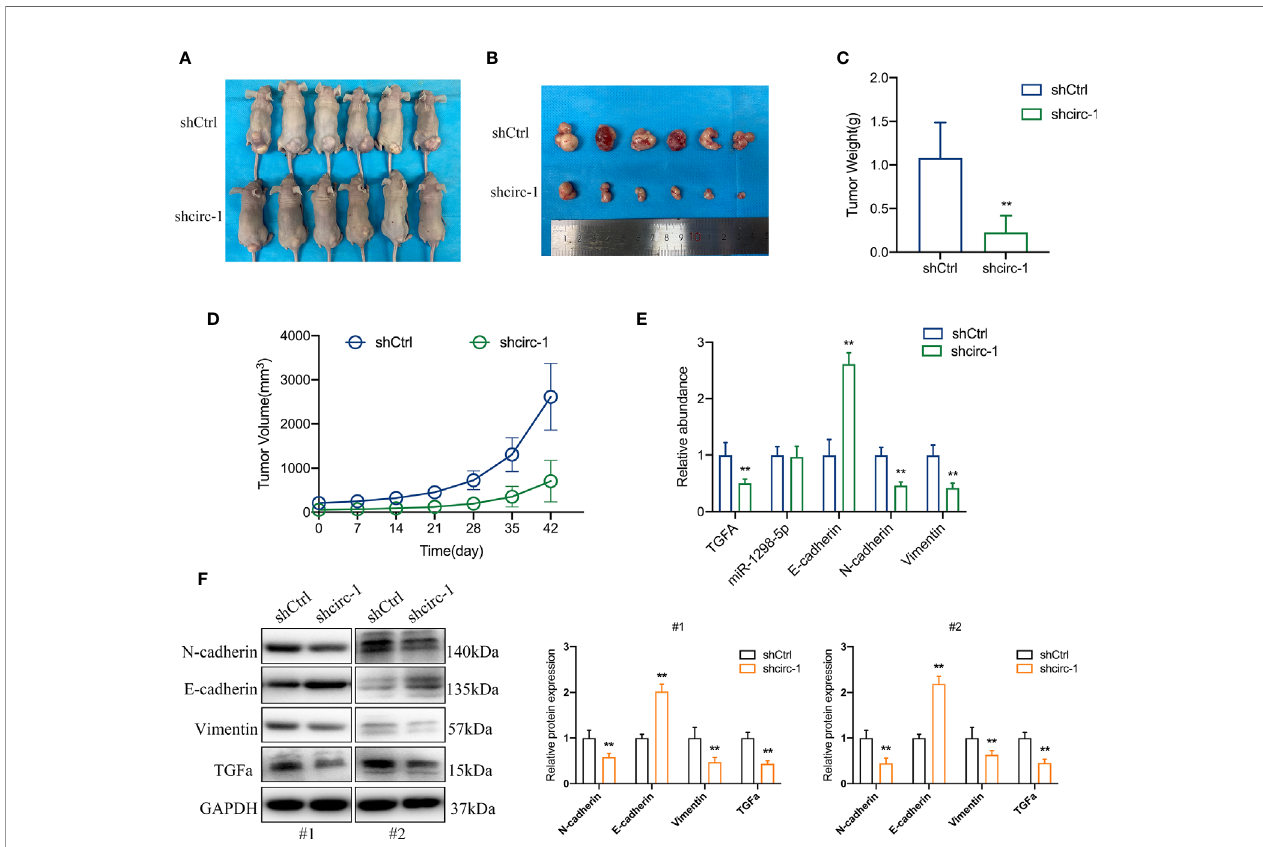
FIGURE 7 | Silencing of circTAF4B suppressed the growth and EMT process of BCa cells in vivo . (A) Nude mice with transplanted tumors were sacri fi ced. (B) Transplanted tumors removed from two groups of nude mice. (C) The tumor weight of the circTAF4B-downregulated group was signi fi cantly lower than that of the negative control group. (D) The volume of tumors in both groups was measured weekly. (E) The expression levels of TGFA, miR-1298-5p and EMT markers in the circTAF4B downregulated group and negative control group. (F) western blotting assays showed that silencing circTAF4B downregulated N-cadherin, vimentin and TGF a expression and upregulated E-cadherin expression. Data represent the mean ± SD of more than three independent experiments. *p < 0.05; **p <